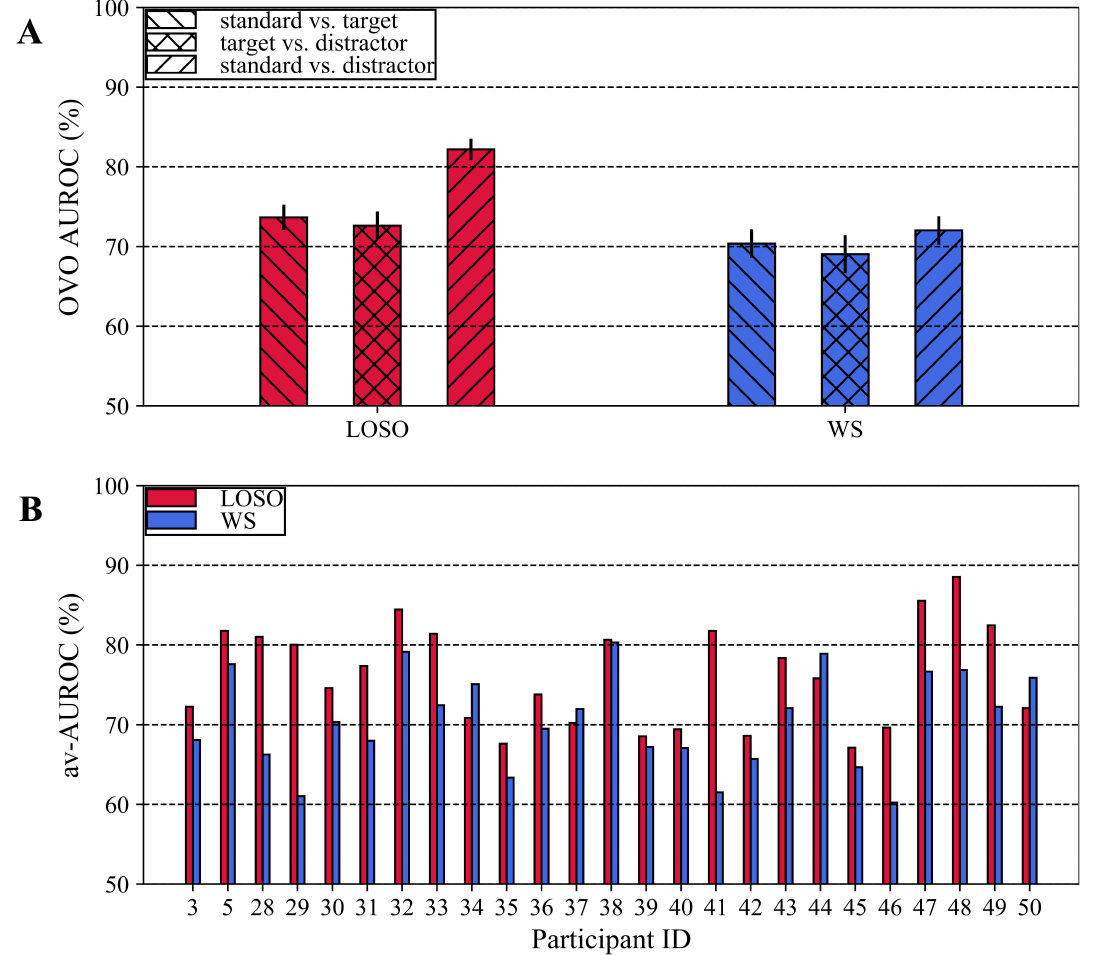
Fig.5. CNNperformance. (A) One-vs-one AUROCs using LOSO (red bars) and WS (blue bars) strategies. The height of bars denotes the mean value across subjects, while the error bar denotes the standard error of the mean. (B) Multi-class AUROCs (also referred as av-AUROCs in the manuscript) at the level of single subject obtained with the LOSO (red bars) and WS (blue bars) strategies. Note that the participant ID reported on the x-axis reflects the participant ID of the